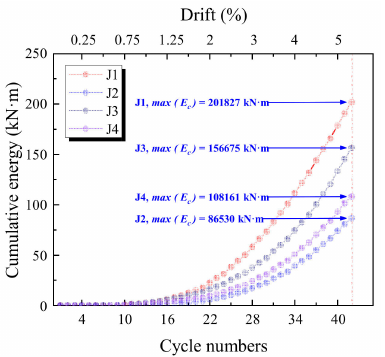
Figure 18. Cumulative